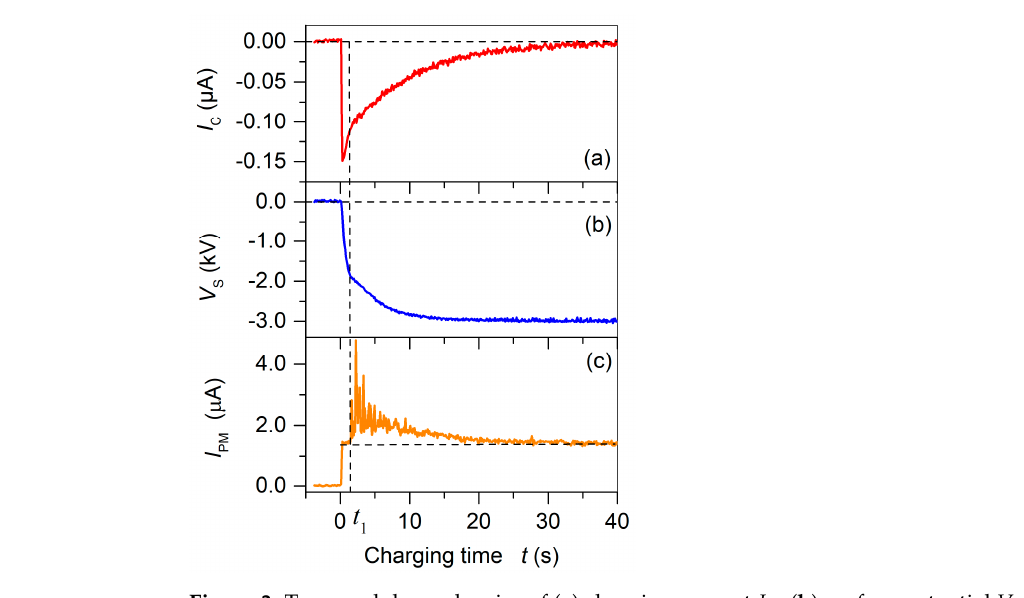
Figure 3. Temporal dependencies of ( a ) charging current I C , ( b ) surface potential V S , and ( c ) photo- multiplier current I PM for poling of a virgin sandwich of alternating FEP/TPU/FEP and FEP/air/FEP elements with a width ratio of 1 at V G = − 3.0 kV. The corona voltage was switched on at time t = 0 s. Time t 1 indicates the onset of breakdown-induced light emission and polarization of the sample.